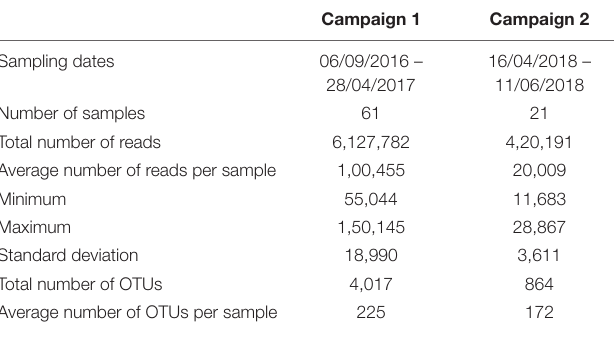
TABLE 2 | Summary of the data analysis performed for the first and second sampling